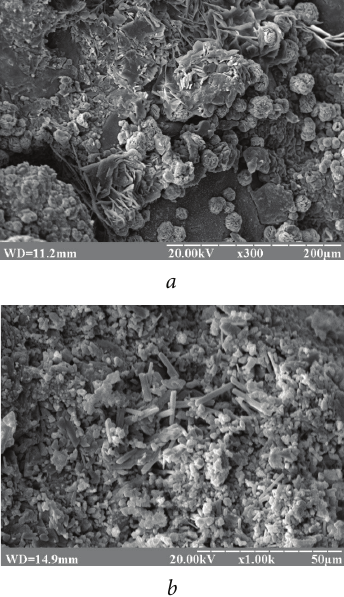
Fig. 6. Electron microscopic image of the concrete